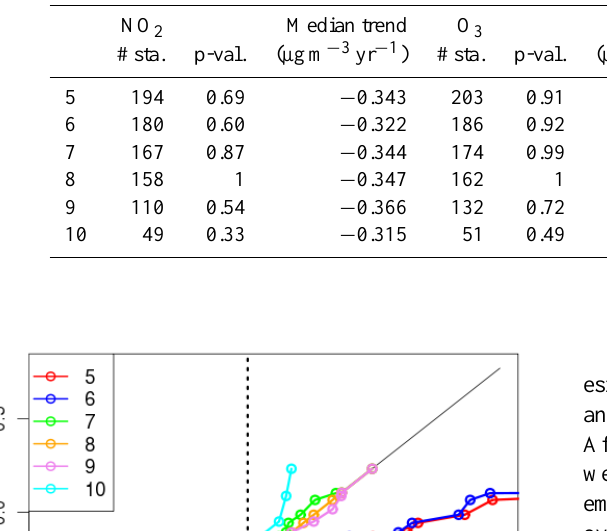
Table 2. Sensitivity of the trend computed in the Benelux region to the threshold used in the quality checking procedure. For each minimum number of years covered and each pollutant, we provide the number of available stations, the p-value of the Wilcoxon test of similarity of the distributions compared to the reference (with a 8-yr threshold), and the median of the distribution of the trends at all stations.